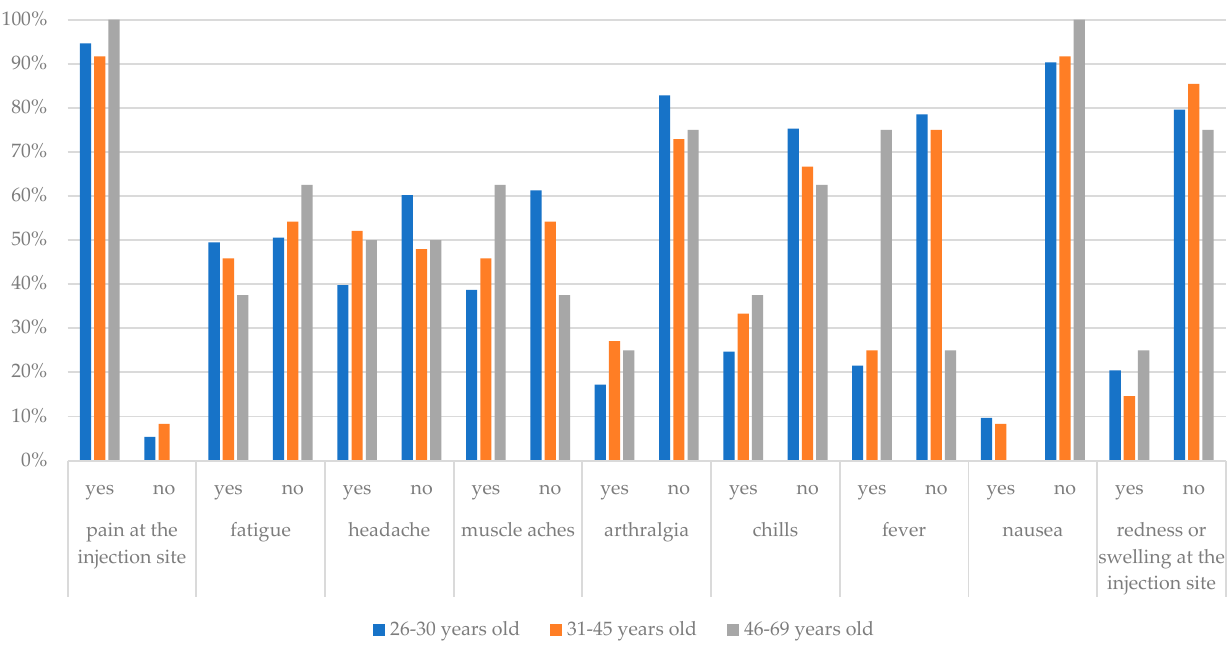
Figure 3. Comparison of the number of side effects after taking the vaccine with age.